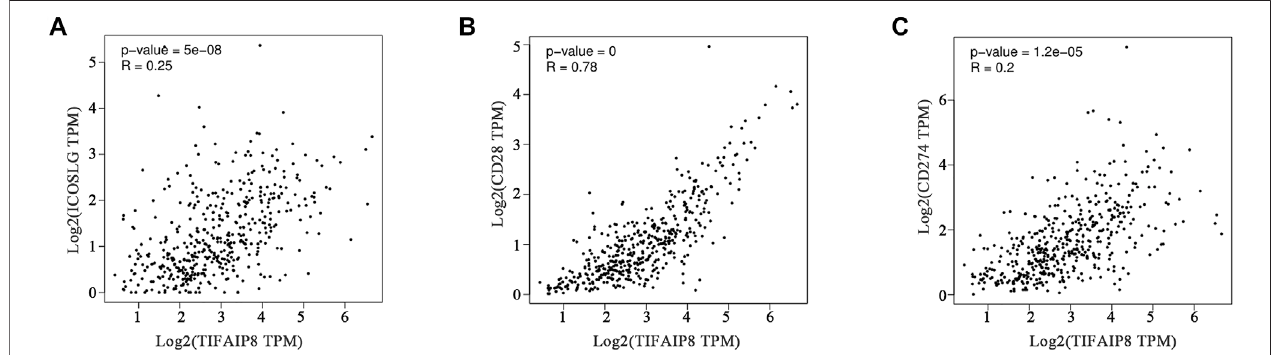
FIGURE 9 | Correlation analysis between the TNFAIP8 expression and ICOSLG (A) or CD28 (B) or CD274 (C)